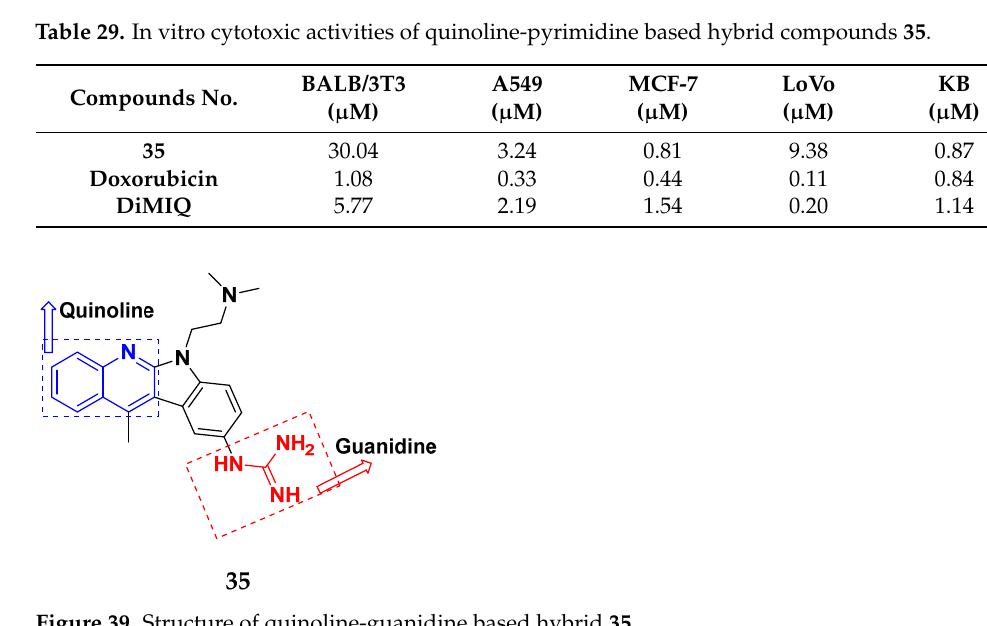
Figure 39. Structure of quinoline-guanidine based hybrid 35.